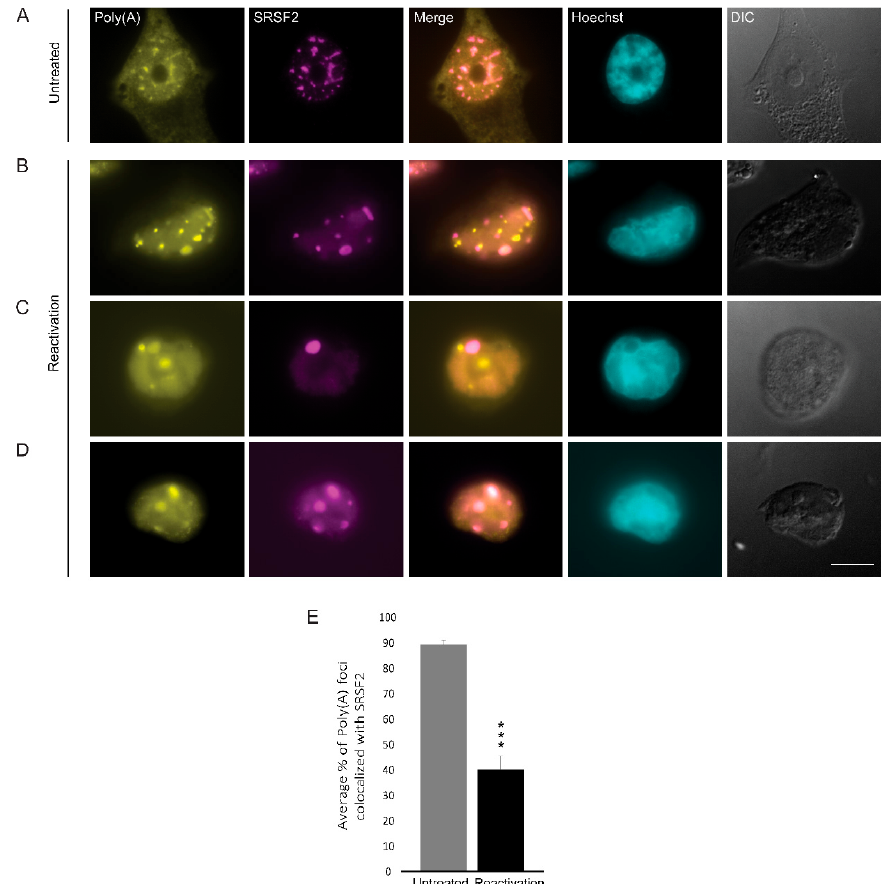
Figure 6. The distribution of poly(A)+ RNA during lytic reactivation of KSHV infection. Poly(A)+ RNA (yellow) was detected by RNA FISH using a Cy3-labeled oligo-dT probe (yellow) in ( A ) untreated cells compared to ( B – D ) BAC16-infected iSLK cells that were treated to induce the lytic cycle of KSHV infection for 48 h and stained with anti-SRSF2 (magenta); Hoechst in cyan; DIC in grey. Bar, 10 µ m. ( E ) Measurements of the average percent of Poly(A) foci that colocalized with SRSF2 nuclear speckles (nUntreated = 55, nReactivation = 35 cells) (*** p <